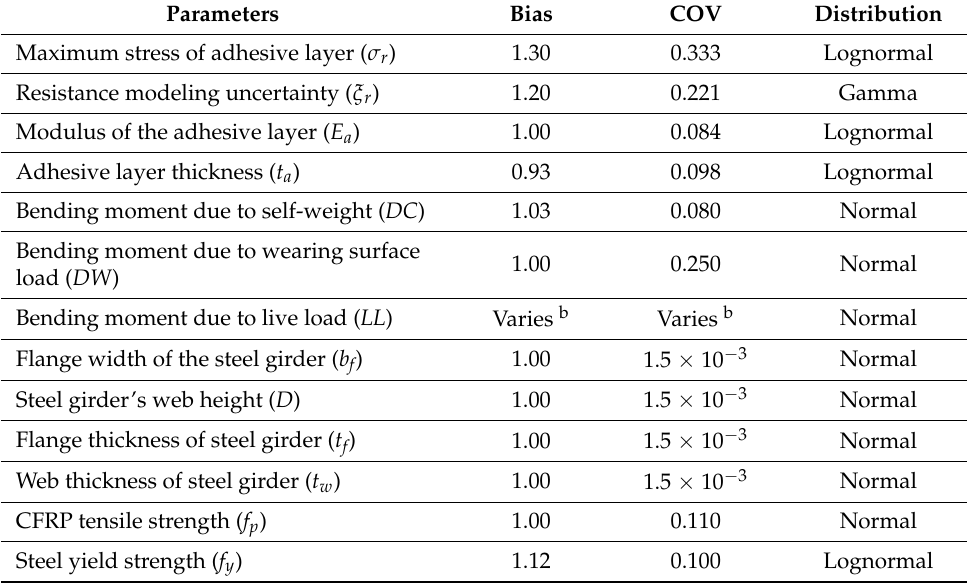
Table 5. The statistical characteristics of